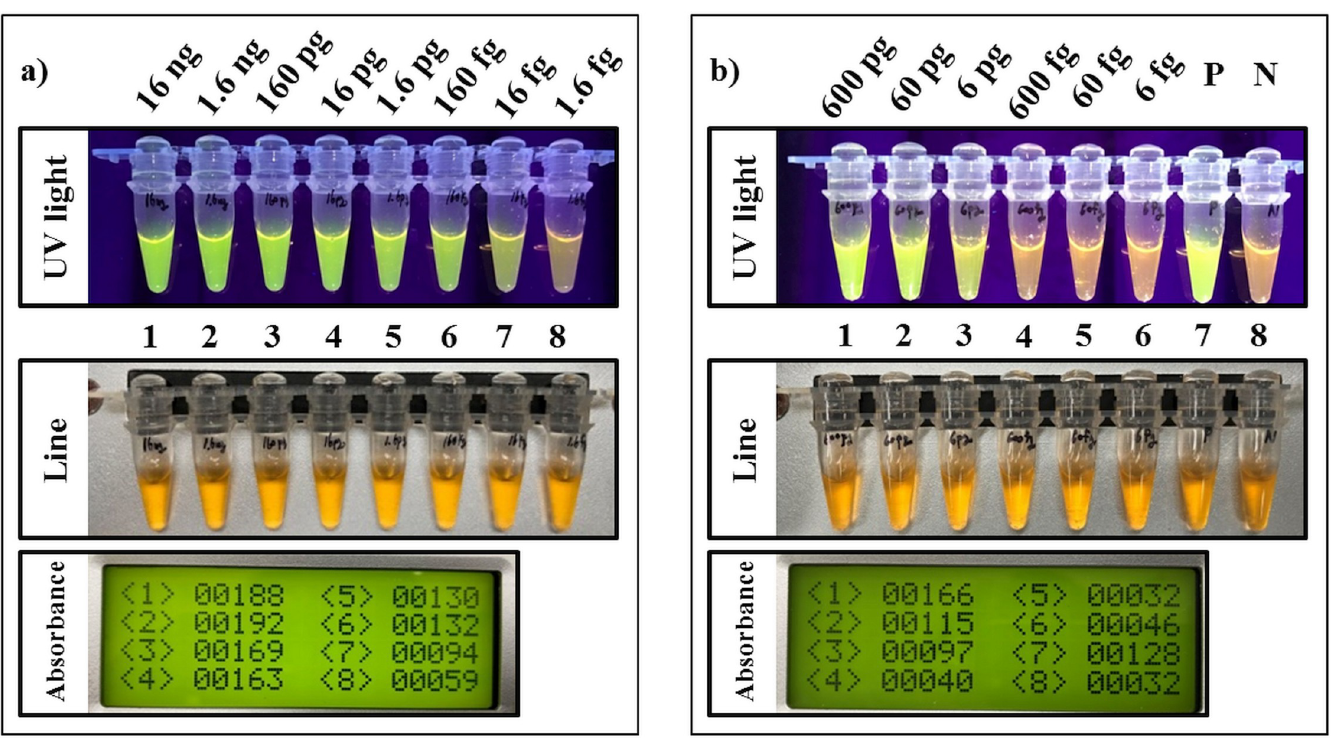
Fig 5. The evaluation of the limit of detection (LOD) in the RPA assay for B . xylophilus . First, a) The RPA assay used a ten-fold serial dilution of pure gDNA of B . xylophilus to measure the LOD under conditions without any interference except pure gDNA. Second, b) For the measurement for the pinewood sample LOD, RPA assay used the lysates were made by healthy pinewood mixed with the pure gDNA of B . xylophilus , which was then extracted by DAP buffer to measure the LOD under conditions with all interferences come from the pinewood with DAP buffer. P and N represent the positive control using pure gDNA from B . xylophilus and the negative control using healthy pine tree lysate extracted by DAP buffer. The line numbering is matched with absorbance numbering in each panel.